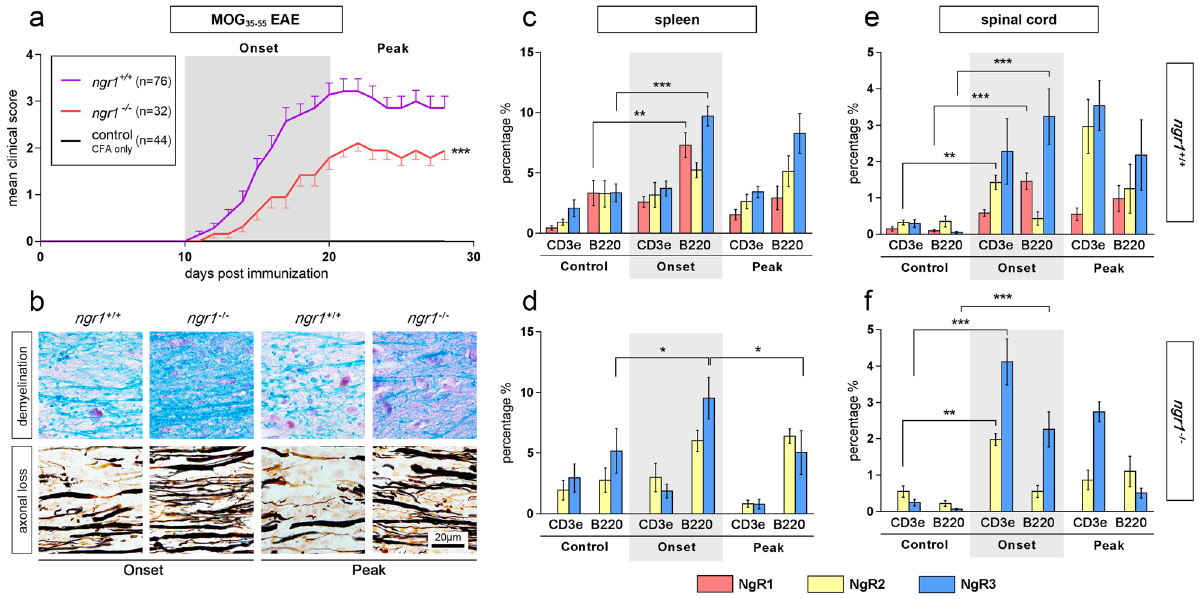
Figure 1. The onset of MOG 35-55 -induced EAE mice is accompanied by an increase in NgR1 + and NgR3 + immune cell populations. ( a ) There was a significant delay in the onset of EAE and reduction in severity for the ngr1 −/− (n = 32; red line) compared to ngr1 + / + mice (n = 76; purple line) within the 2 main phases studied; onset (days 10–20 post-immunization; 10–20 dpi) and peak (days 20–30 post-immunization; 20–30 dpi). A control group (CFA-injected only; n = 44; black line) was also included. Daily clinical scores represent mean ± SEM, *** p < 0.001 (from day 15 until end-point), two-way ANOVA. ( b ) The severity of demyelination and axonal loss was also reduced in the spinal cord of ngr1 −/− EAE-induced mice, for both onset and peak phases, determined by Luxol fast blue (LFB)/Periodic acid-Schiff (PAS) and Bielschowsky silver stain, respectively. ( c , d ) Flow cytometric analysis of double-labeled cell suspensions is from the spleen of both ngr1 + / + and ngr1 −/− mice showed an elevated NgR3 expression in B-cells (B220 + ) at the onset of EAE (n = 5; t test *** p < 0.001 and * p < 0.05 compared to controls, respectively) along with a concomitant increase of NgR1 in ngr1 + / + mice (n = 5; t test ** p < 0.01). B-cells co-expressing NgR3 were subsequently reduced in the peak stage of EAE (n = 5; t test * p < 0.05) in ngr1 −/− mice that exhibited disease signs. The NgR2 homolog did not manifest any discernible significant increase in either ngr1 + / + or ngr1 −/− mice. ( e , f ) The percentages of double labeled immune cells isolated from the spinal cord in EAE-induced mice were again significantly elevated for NgR3 and NgR1 during the onset of disease, compared to controls (n = 5; t test *** p < 0.001 for both). Interestingly, deletion of the ngr1 gene in ngr1 −/− mice incurred an NgR3 and NgR2 upregulation in T-cell (CD3e + ) populations (n = 5; t test *** p < 0.001 and ** p < 0.01 compared to controls, respectively). B220: B-cell marker; CD3e: T-cell marker. Bars represent mean ± SEM, * p < 0.05, ** p < 0.01, *** p <